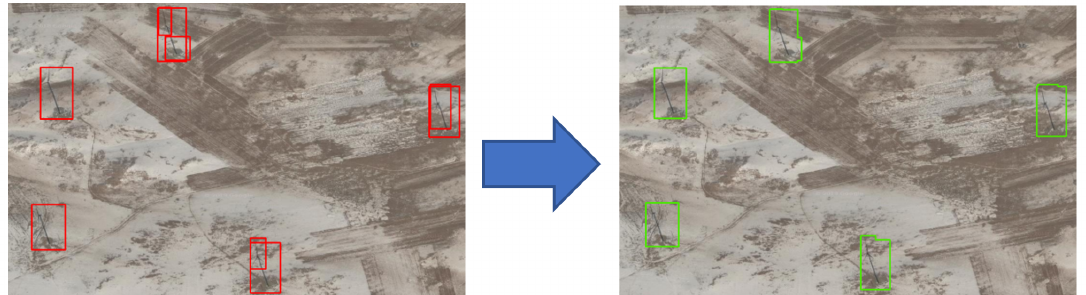
Figure 10. Aggregated polygons on the initial result. The overlapping and closed objects were